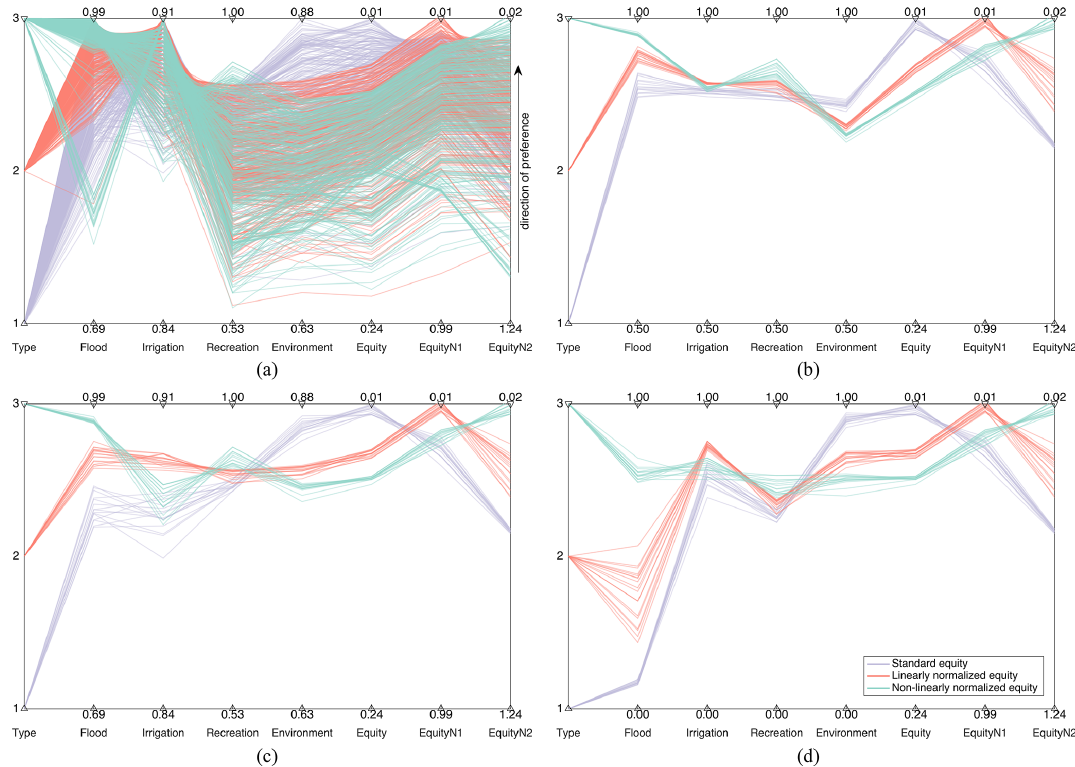
Figure 8. Parallel plot of (a) all solutions and (b, c, d) 5% solutions with the lowest (standard, linearly normalized, or non-linearly nor- malized) equity index in problem formulation F2. Type 1, 2, and 3 refer to optimizations minimizing the standard, linearly normalized, and non-linearly normalized equity index, respectively. Panels (a) , (b) , and (c) show the performance value, whereas panel (d) shows the performance scores; panels (b) and (d) have the same lower and upper bounds for all axes (of J F , J I , J R , and J E ) , whereas panels (a) and (c) use the minimum and maximum performance values of problems F1–F4 as the lower and upper axis